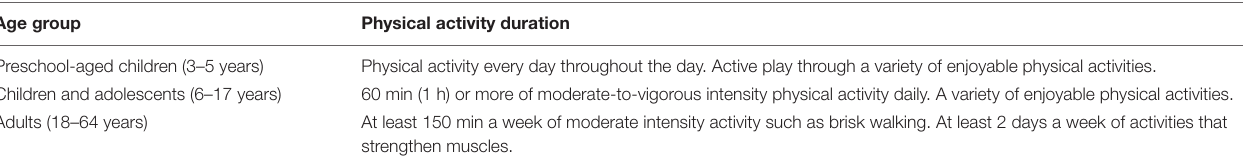
TABLE 6 | Recommended physical activity (PA) based on age